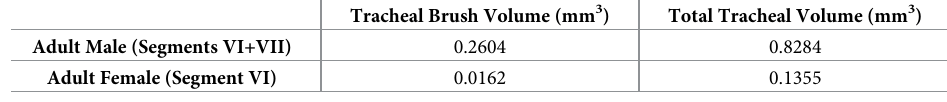
Table 5. Volume of the tracheal brush in adult male and female Photinus pyralis .